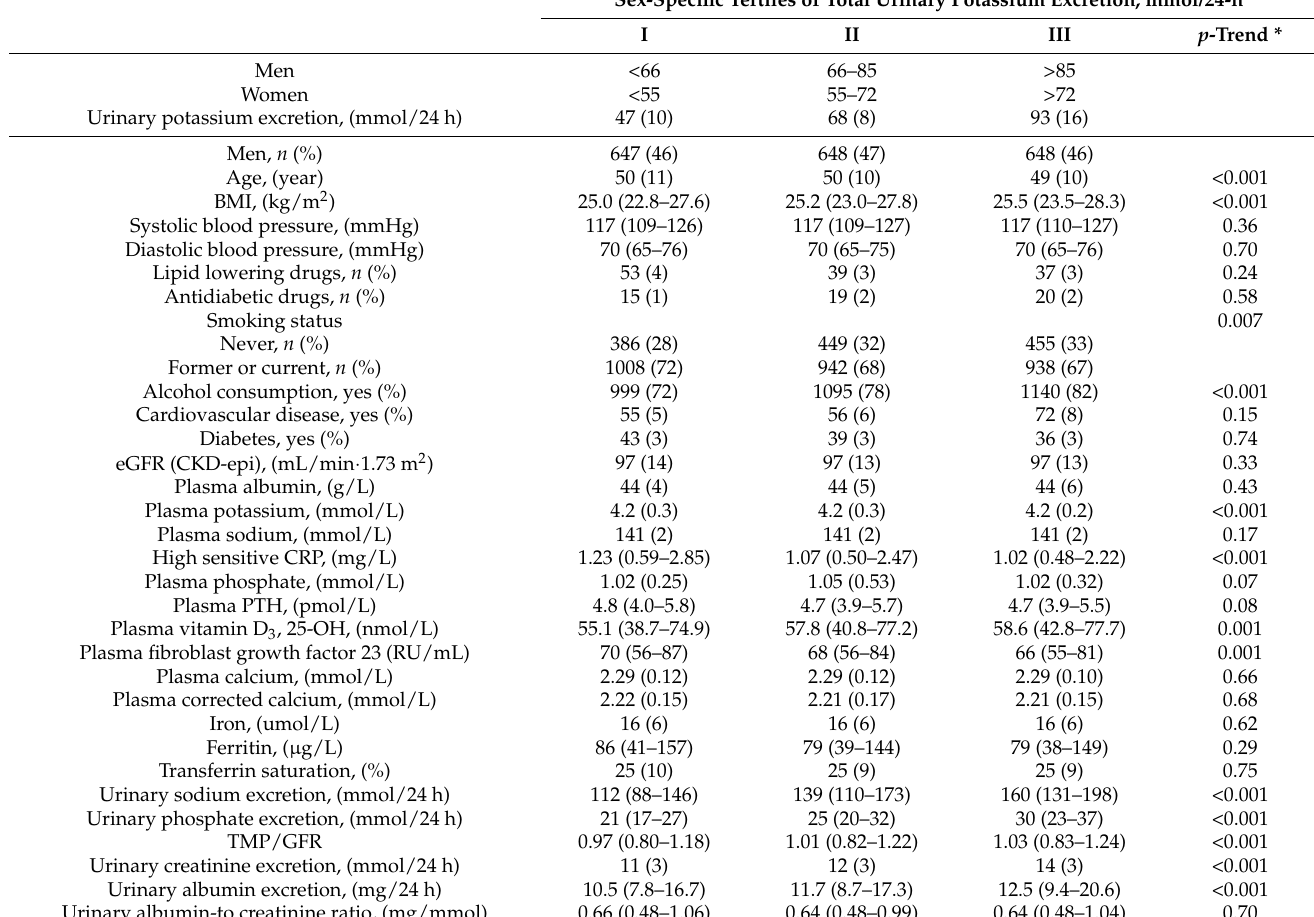
Table 1. Baseline parameters according to sex-specific tertiles of urinary potassium excretion in 4194 participants of